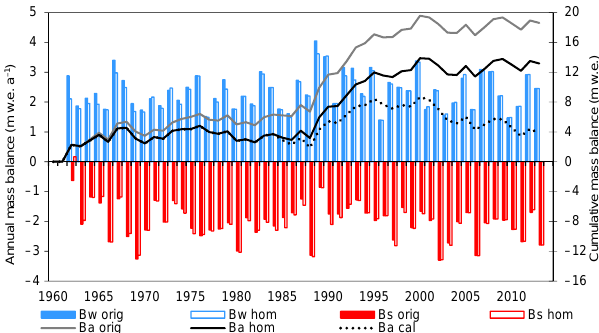
Figure 5. Original, homogenised, and calibrated mass-balance se- ries for Nigardsbreen. Annual values are shown for B w and B s and cumulative values are shown for B a . See Table S1 for individual